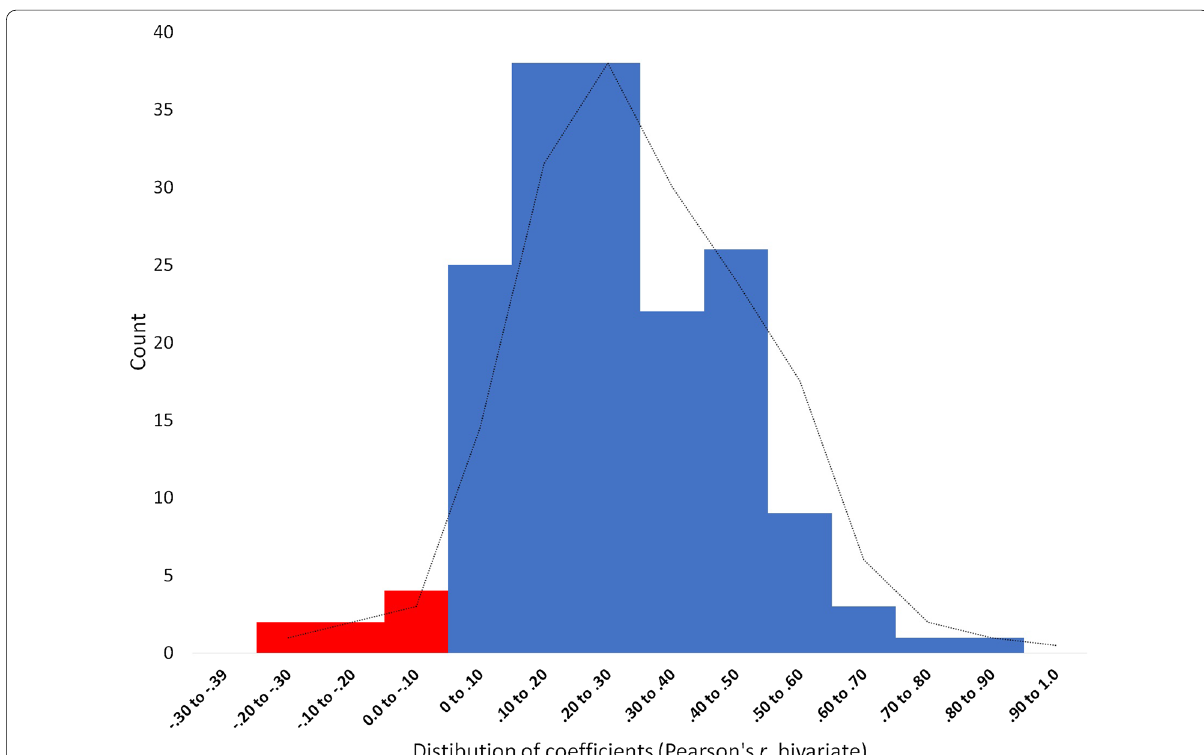
Fig. 2 Histogram of the Frequency (Count) of Distributions of Bivariate Correlations Between Group IQ Items (within study). Note. The frequency of negative and positive correlations between group IQ test items is represented by red and blue bars, respectively. The dotted line –- represents the trendline for the average